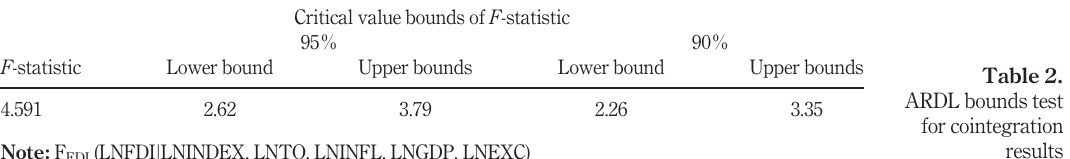
Table 2. ARDL bounds test